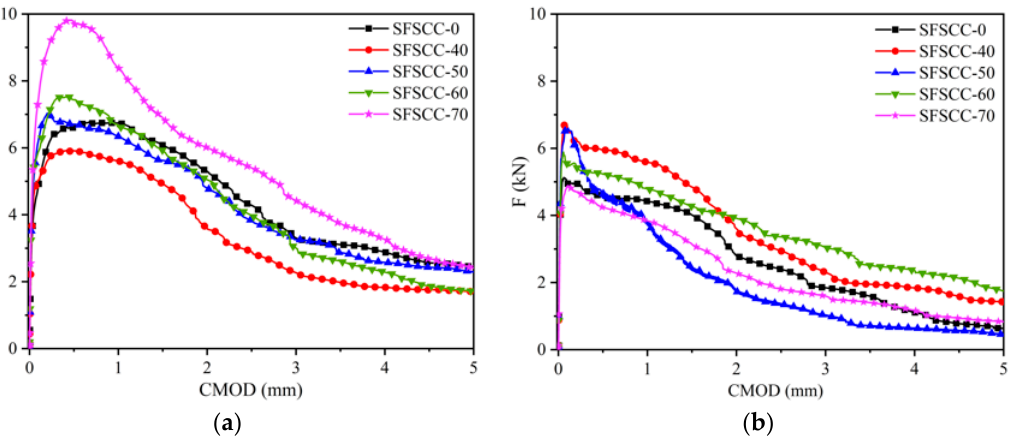
Figure 5. F–CMOD curve of SFSCC before and after dry–wet cycle sulfate attack. ( a ) Original SFSCC. ( b ) Sulfate attacked